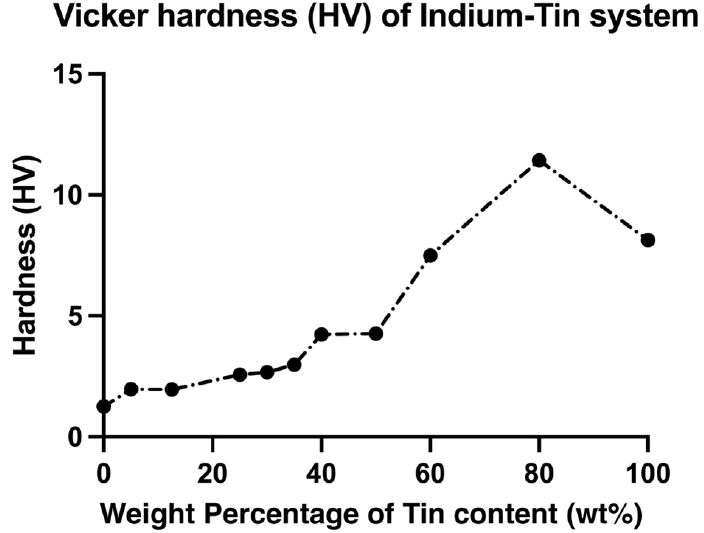
Figure 4. Elongation to failure compared to tin content in In-Sn solder alloys under two strain rates.